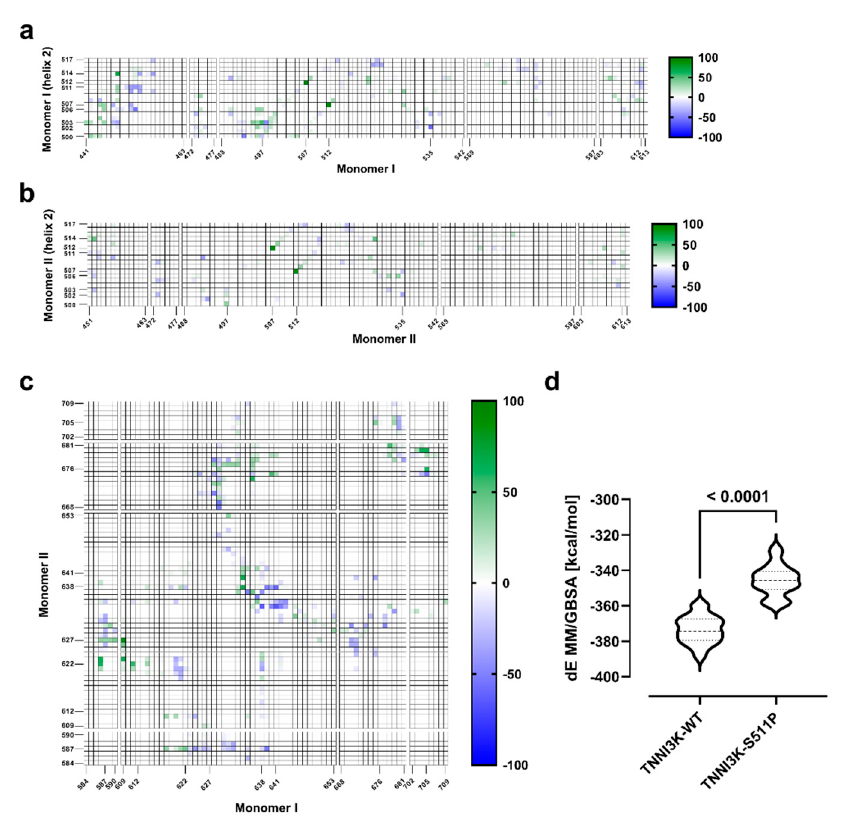
Figure 3. Average intra/inter residue-residue contact maps and MM/GBSA analysis. ( a ) Contact map of the residues of helix 2 in monomer I and the residues of the corresponding monomer, and ( b ) residues of helix 2 in monomer II and the residues of the corresponding monomer. Each point represents the mean of the average residue-residue contact difference between TNNI3K-WT and TNNI3K-S511P over the last 200 ns from the three independent MD simulations (spectrum range from green to white to blue, from 100% to − 100% contact; green means more contacts in TNNI3K-WT and blue means more contacts in TNNI3K-S511P). ( c ) Contact map between residue-residue pairs in the dimer interface for TNNI3K-WT vs. TNNI3K-S511P. The contact spectrum ranging from green to white to blue, representing 100% to − 100% contact, where green indicates more contacts in TNNI3K- WT and blue indicates more contacts in TNNI3K-S511P. Each point represents the mean difference in the residue-residue contact over the last 200 ns from the three independent MD simulations. ( d ) MM/GBSA analysis applied for dimerization of TNNI3K. Every 10th snapshot of the last 200 ns of the MD simulation was used. Each violin plot represents the mean from the three independent simulations (95% confidence